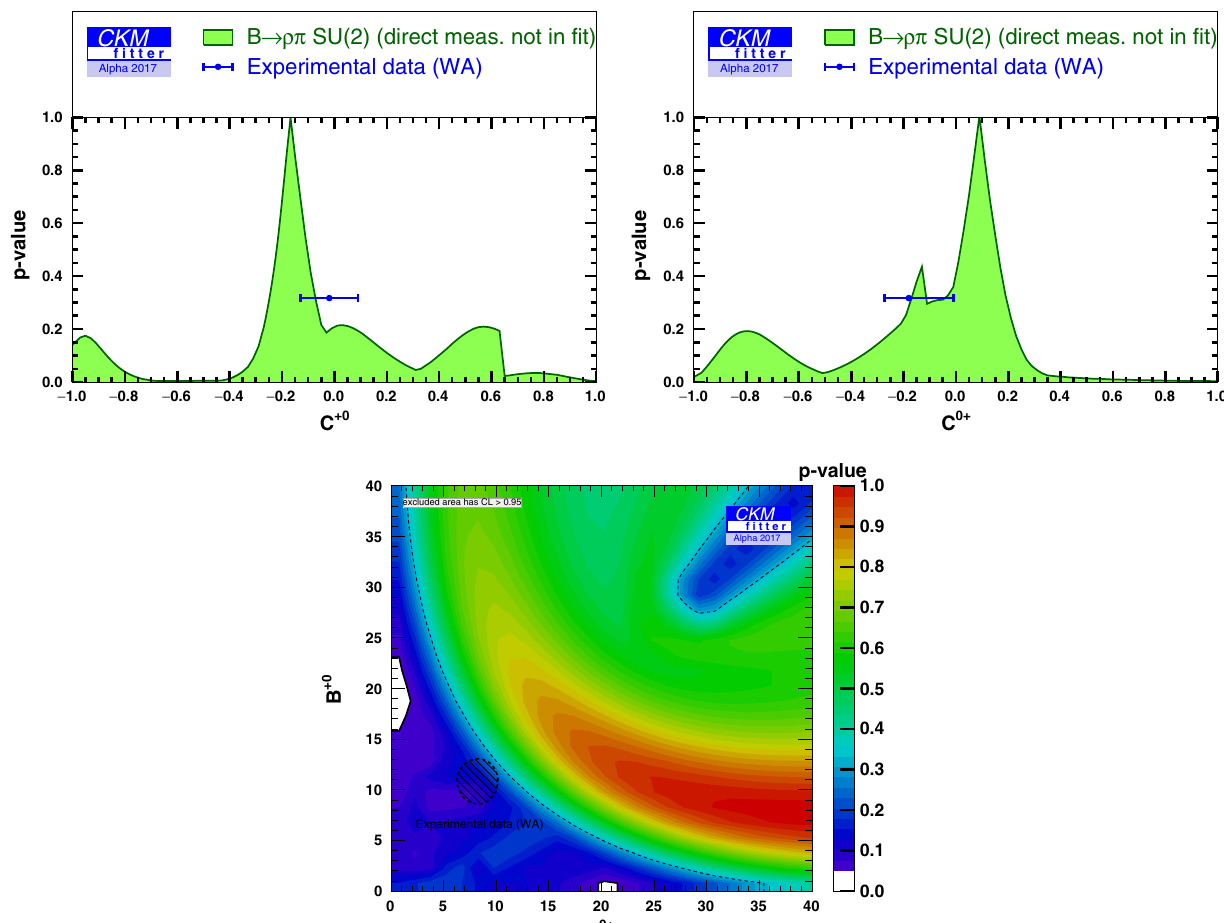
Fig. 40 Constraint on the branching fraction and the direct CP asym- metry of the charged B + → ρ + π 0 mode ( top , left ) and B + → ρ 0 π + mode ( top , right ). For each observable, the direct measurement, not included in the fit, is indicated by an interval with a dot . The bottom fig-